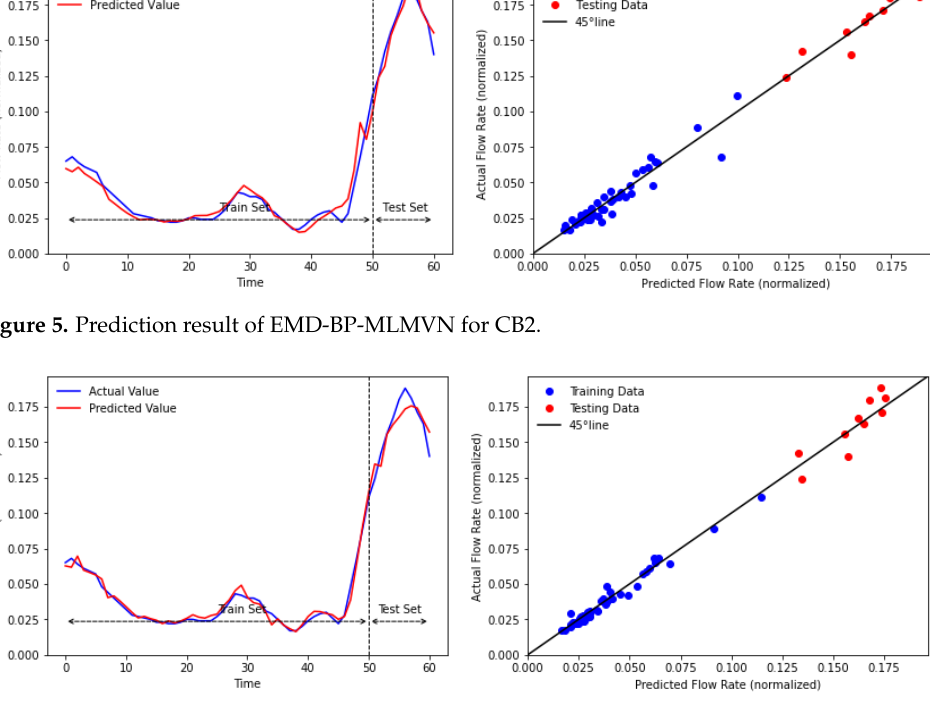
Figure 6. Prediction result of EMD-BP-HONN for CB2.